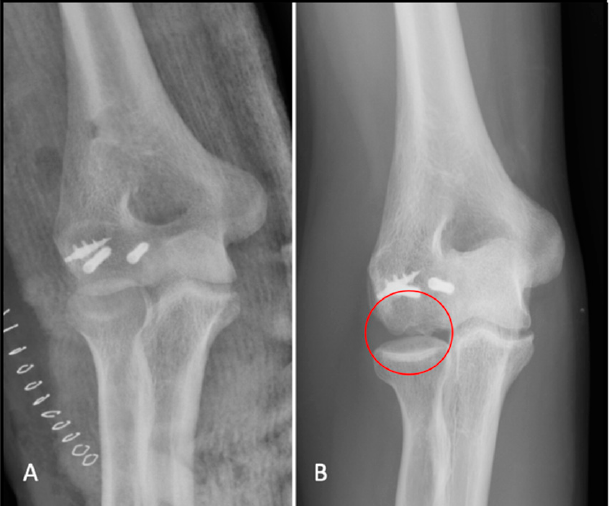
Figure 9. ( A ) Post-operative X-ray; and ( B ) signs of avascular necrosis circled on the follow-up X-ray. Heterotopic ossification is reported in 0% to 38% of cases. They are usually low grade, according to Brooker, and rarely symptomatic [2,6,13,14,26,51,71]. Ulnar neuropathy is rare and can be transient